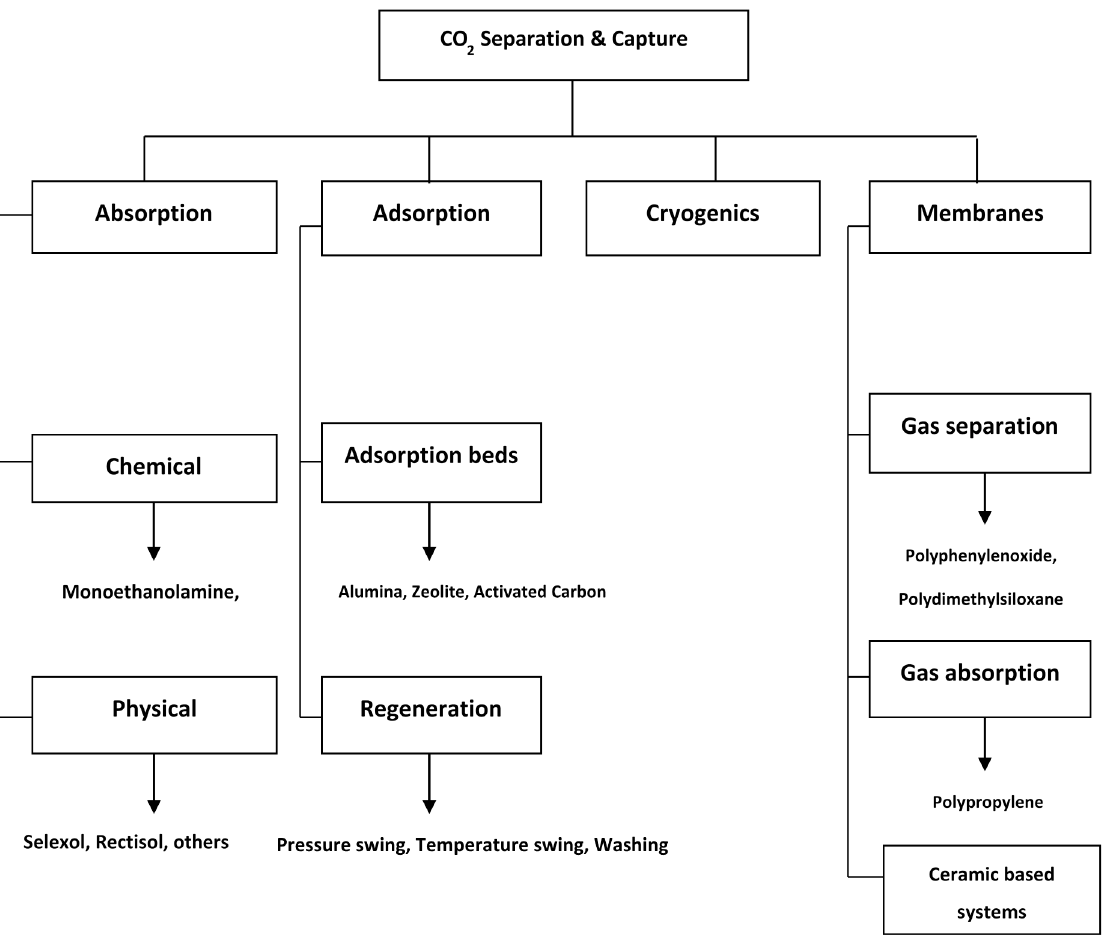
Figure 1. Different CO 2 separation and capture technologies for post-combustion CO 2 capture [82].